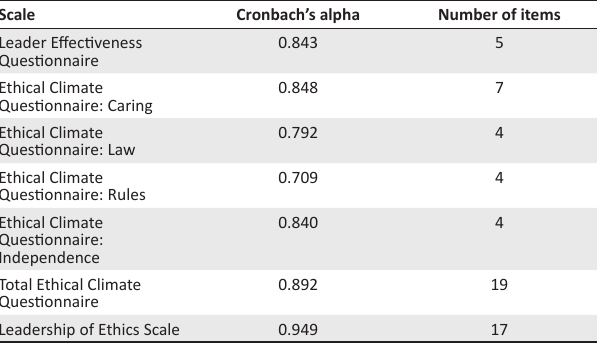
TABLE 1: Reliability of measurement scales. Scale